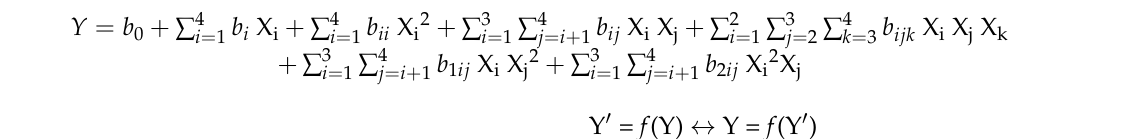
* Coefficient of variation of the central point repetition (Runs: